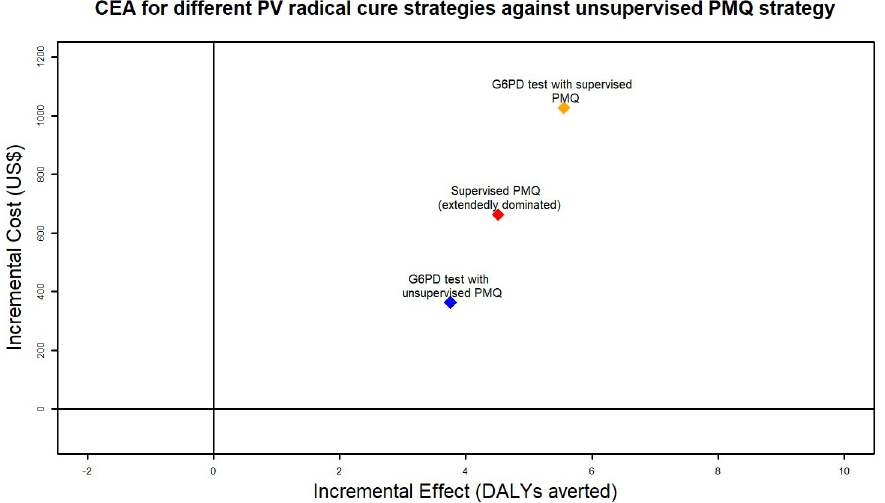
Fig 7. ICERs of each Pv radical cure strategy against conventional strategy (unsupervised PMQ strategy) plotted on cost-effectiveness plane.